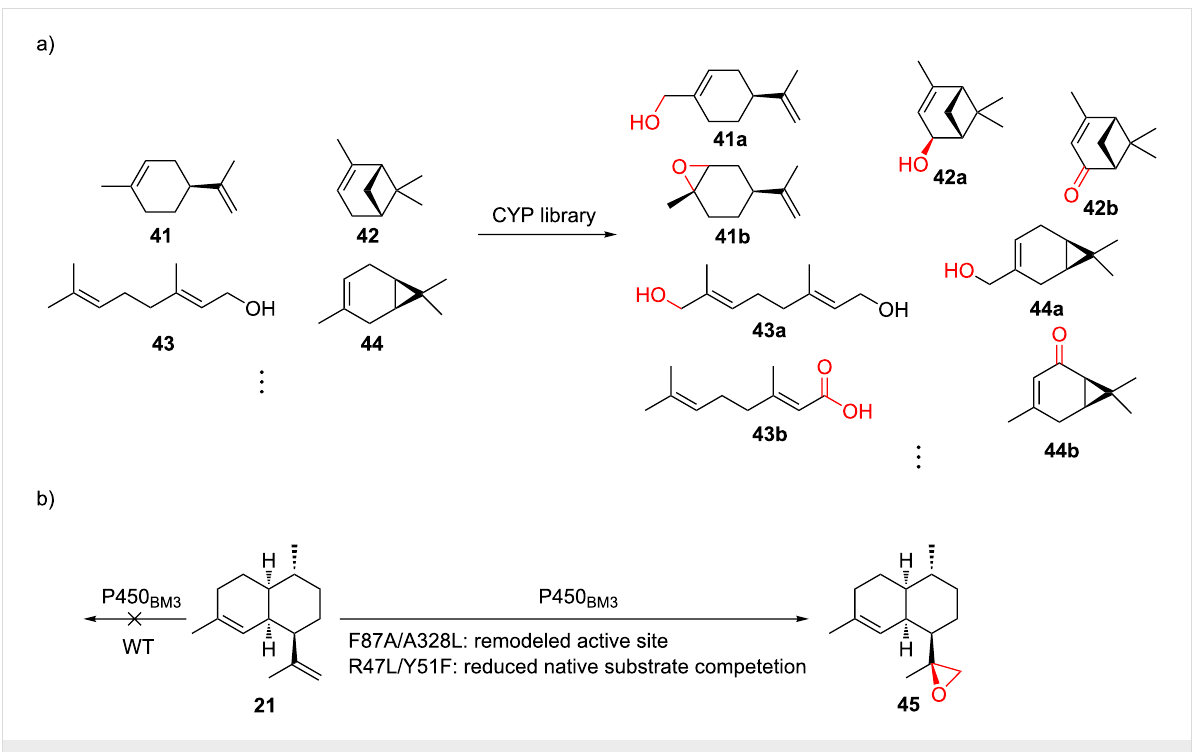
Figure 10: Substrate promiscuity and engineering of CYPs. a) Selected examples from using a CYP library to oxidize various monoterpenes. b) Rational engineering of P450 BM3 for epoxidation of amorphadiene ( 21 ). F87A/A328L and R47L/Y51F: